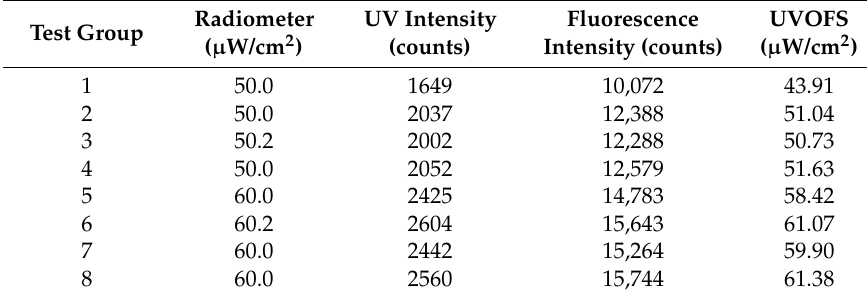
Table 2. The response from radiometer and UVOFS under radiant power density values of 50 and 60 µ W/cm 2 .